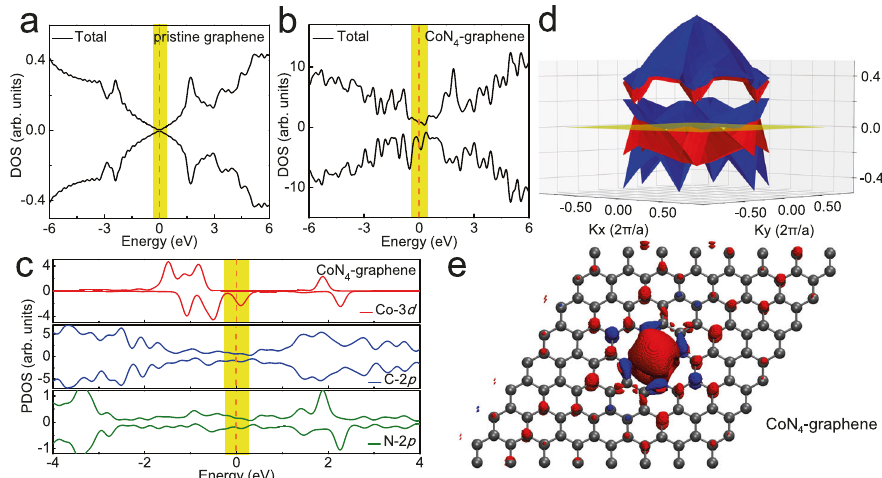
Fig. 5 Electronic structure and origin of ferromagnetism. DFT calculated TDOS for a pristine graphene and b CoN 4 -graphene system. c DFT calculated PDOS for CoN 4 -graphene system. d 2D plot of the energy band structure for CoN 4 -graphene. The red and blue surfaces represent the bands with up and down spin directions, respectively. The transparent yellow plain corresponds to the Fermi level ( E = 0 eV). e Spatial distribution of spin density ( ρ ↑ − ρ ↓ ) for a 8 × 8 × 1 hexagonal graphene supercell with one doped square-planar Co-N 4 structure. Red and blue isosurfaces represent positive and negative spin densities,